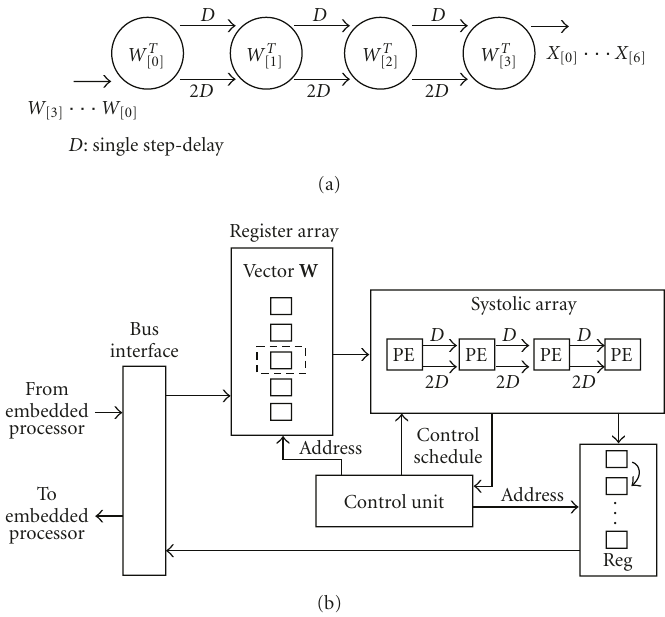
Figure 8: Convolution function: (a) systolic array for performing the 1D convolution; (b) systolic array architecture.